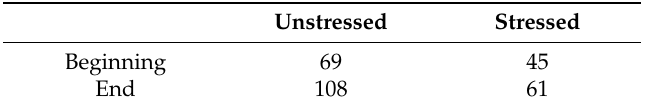
Table A8. Token counts for vowel formant measurements used to visualize vowel space and calculate vowel space area for Informant C in Section 4.2.3.